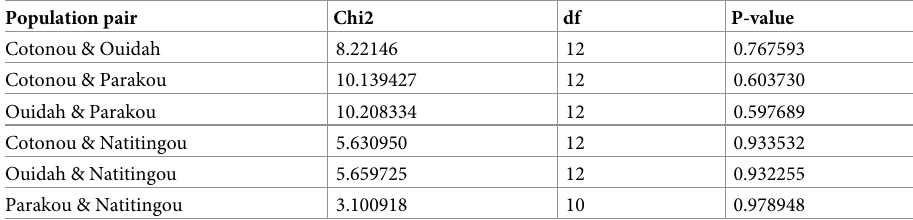
Table 2. P-value for each population pair of Beninese regions across all loci (Fisher’s method). Population pair